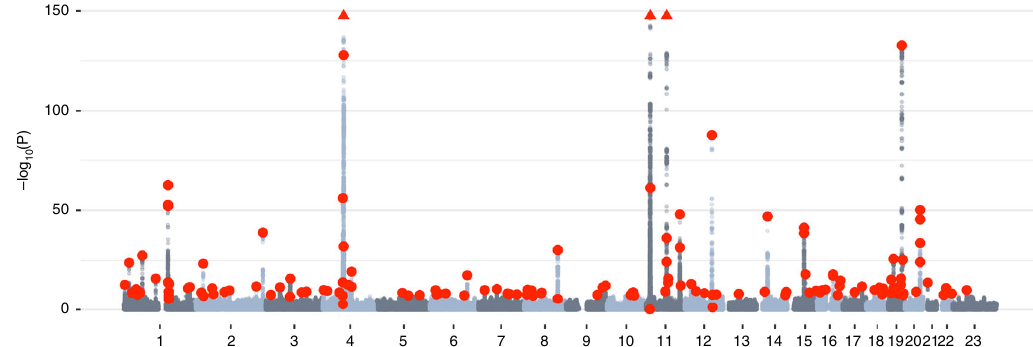
Fig. 3 Manhattan plot of the 25OHD GWAS in the UK Biobank. Manhattan plot showing the − log10 P -values from the fastGWA 62 association test of 25-hydroxyvitamin D (25OHD) with genome-wide SNPs. Red dots represent independent variants identi fi ed as genome-wide signi fi cant with conditional and joint analysis (COJO 18 ) applied to the GWAS summary statistics. The horizontal axis shows each chromosome, with 23 representing the X chromosome. The vertical axis is restricted to − log10 P -values < 150. Five COJO SNPs were associated at P < 1 × 10 − 150 (four on chromosome 11 and one on chromosome 4; Supplementary Data 3) and have approximate locations represented by three red triangles at the top edge of the